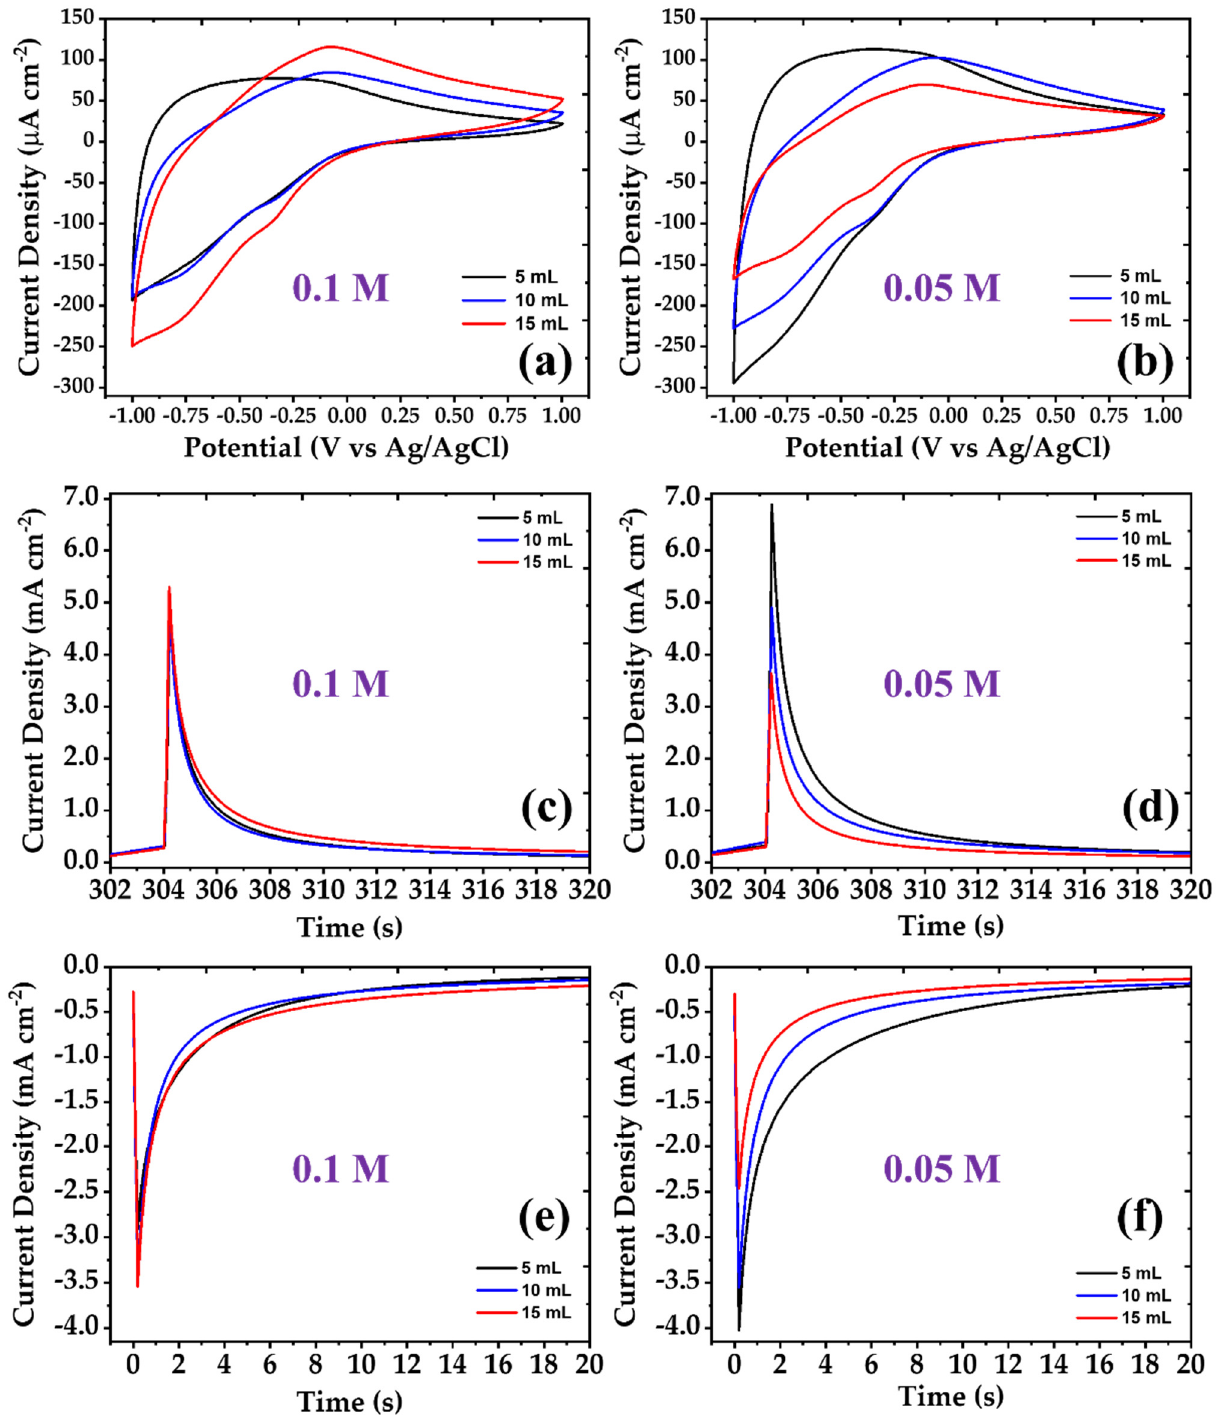
Figure 1. Electrochemical characterization of the 1st cycle of the WO 3 films. ( a ) Cyclic voltammograms of WO 3 films with 0.1 M at a scanning speed of 10 mV sec − 1 ; ( b ) cyclic voltammograms of WO 3 films with 0.05 M at a scanning speed of 10 mV sec − 1 ; ( c ) chronoamperometry of WO 3 films with 0.1 M at a step potential of +1 V (bleaching); ( d ) chronoamperometry of WO 3 films with 0.05 M at a step potential of +1 V (bleaching); ( e ) chronoamperometry of WO 3 films with 0.1 M at a step potential of − 1 V (coloring); ( f ) chronoamperometry of WO 3 films with 0.05 M at a step potential of − 1 V (coloring).